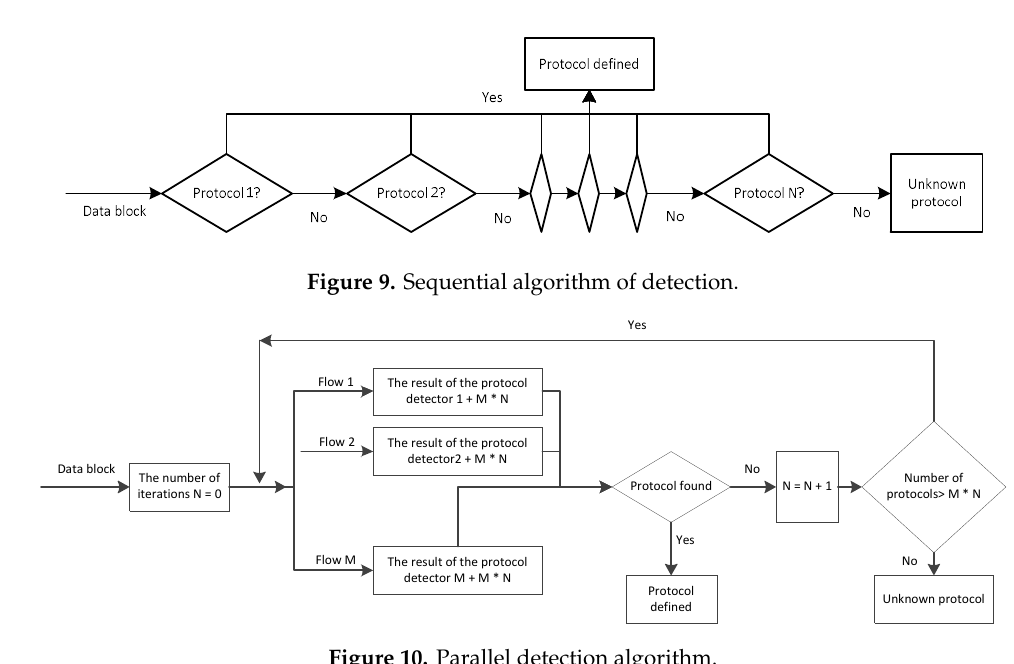
Figure 10. Parallel detection algorithm.